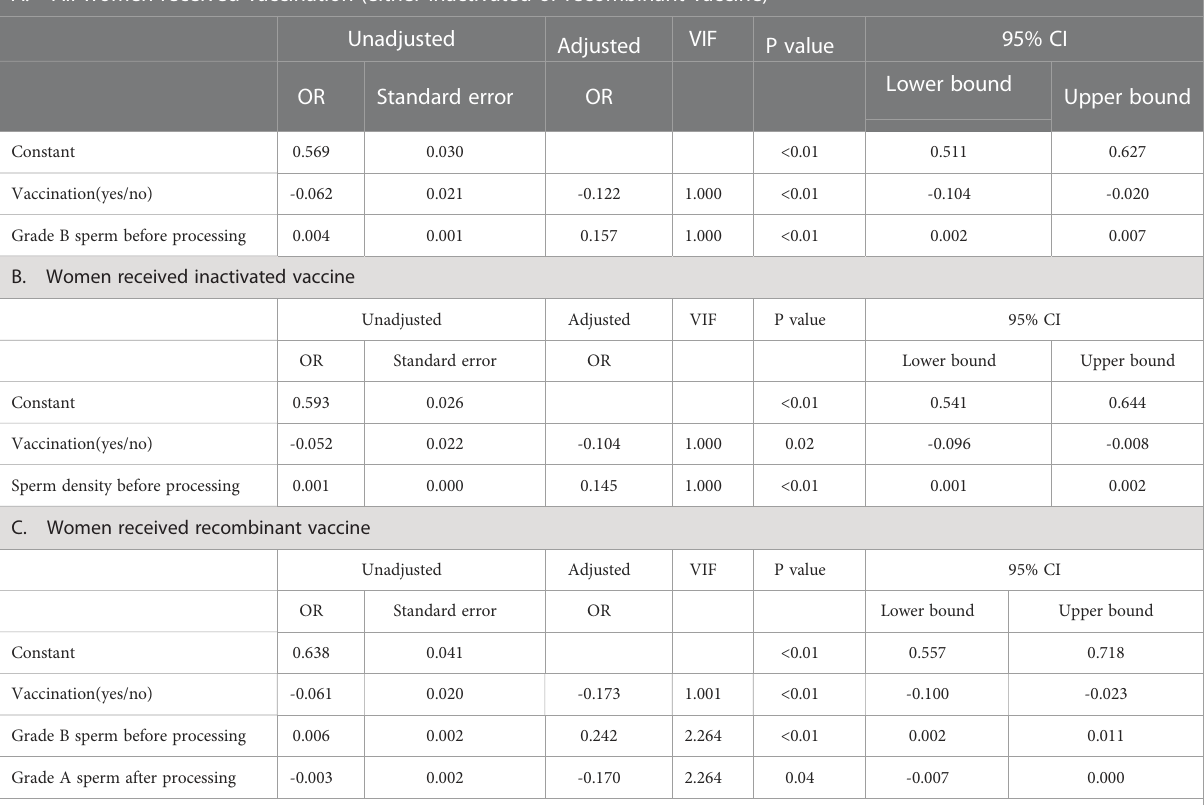
TABLE 4 Multi liner regression analysis on normal fertilization rate (kick-out